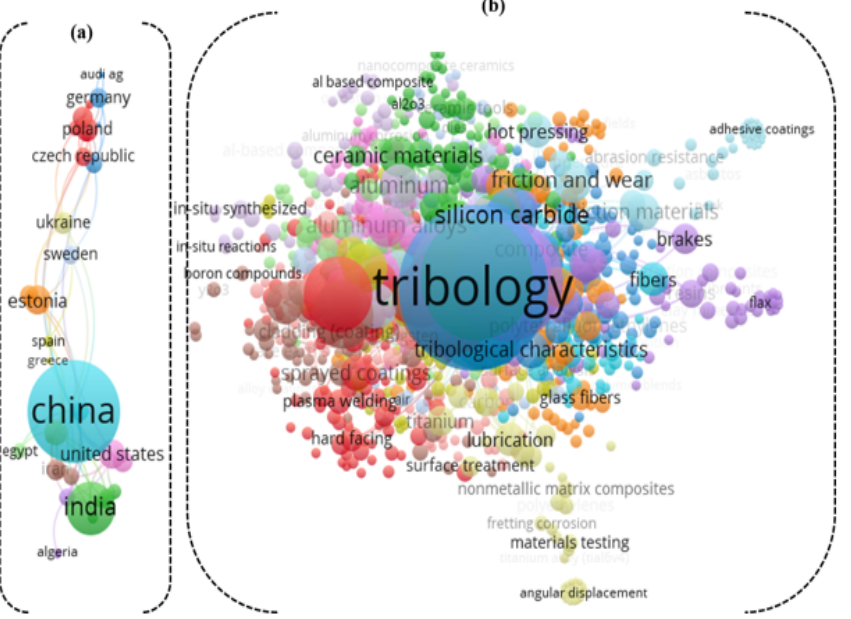
Figure 1. ( a ) Major keywords used in the literature on the abrasive tribology of PTFE-based composites (1989–2021); ( b ) the investigated research areas for abrasive tribology.